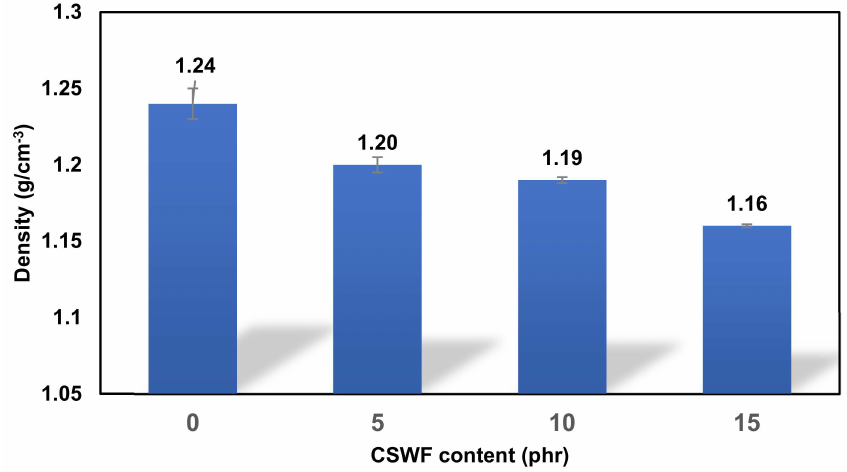
Figure 3. Density of PBS/CSWF composite